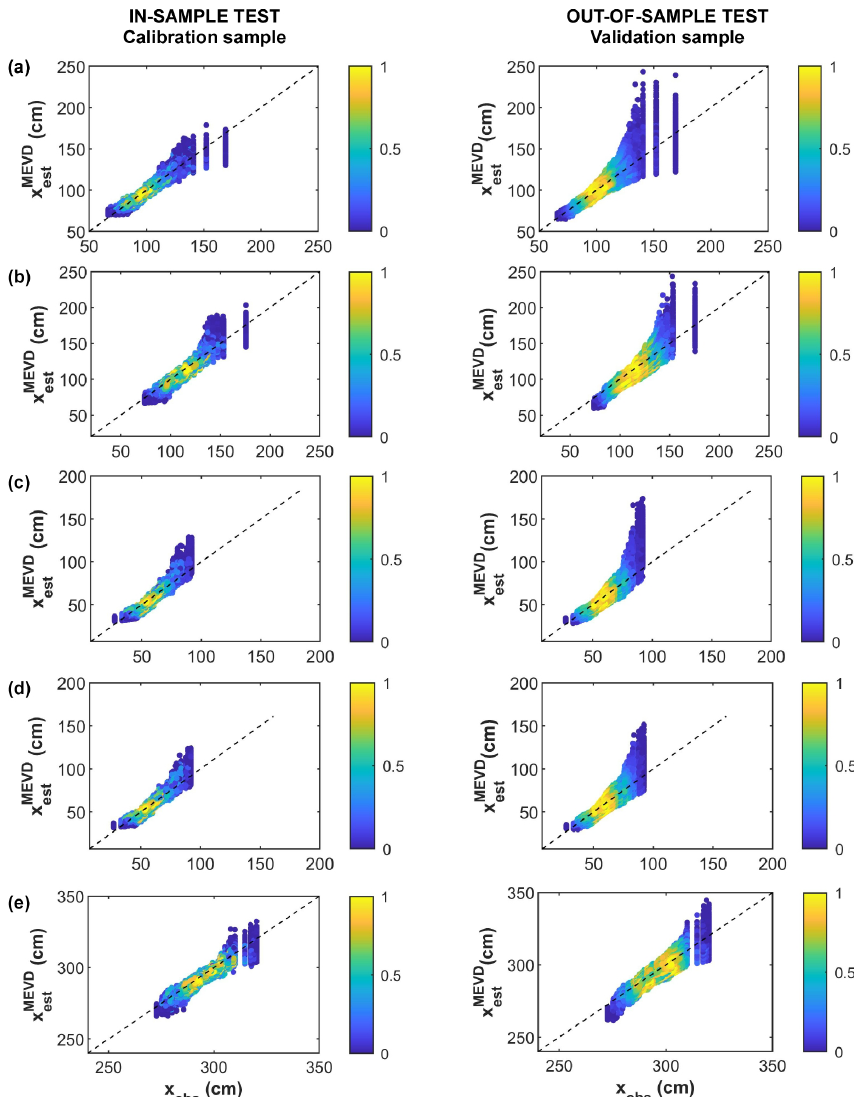
Figure 3. QQ plots of extreme-coastal-water-level quantiles, computed with the MEVD framework, for the (a) Venice (IT), (b) Hornbæk (DK), (c, d) Marseille (FR), and (e) Newlyn (UK) sites. The MEVD parameter estimations are based on non-overlapping sub-samples of fixed size (5 years), while subplots indicated with the letter (d) display the QQ plots obtained with MEVD parameter estimations based on data from the whole calibration sample size. The plots are obtained as a result of the cross-validation method used to test the global performance of the models and are estimated for 1000 random realizations and for sample size (1) S = 30 years (in-sample test in the left column) and (2) V = M − S years (out-of-sample test in the right column). The colors represent the point density around the 45 ◦ line (dashed black line) corresponding to the best